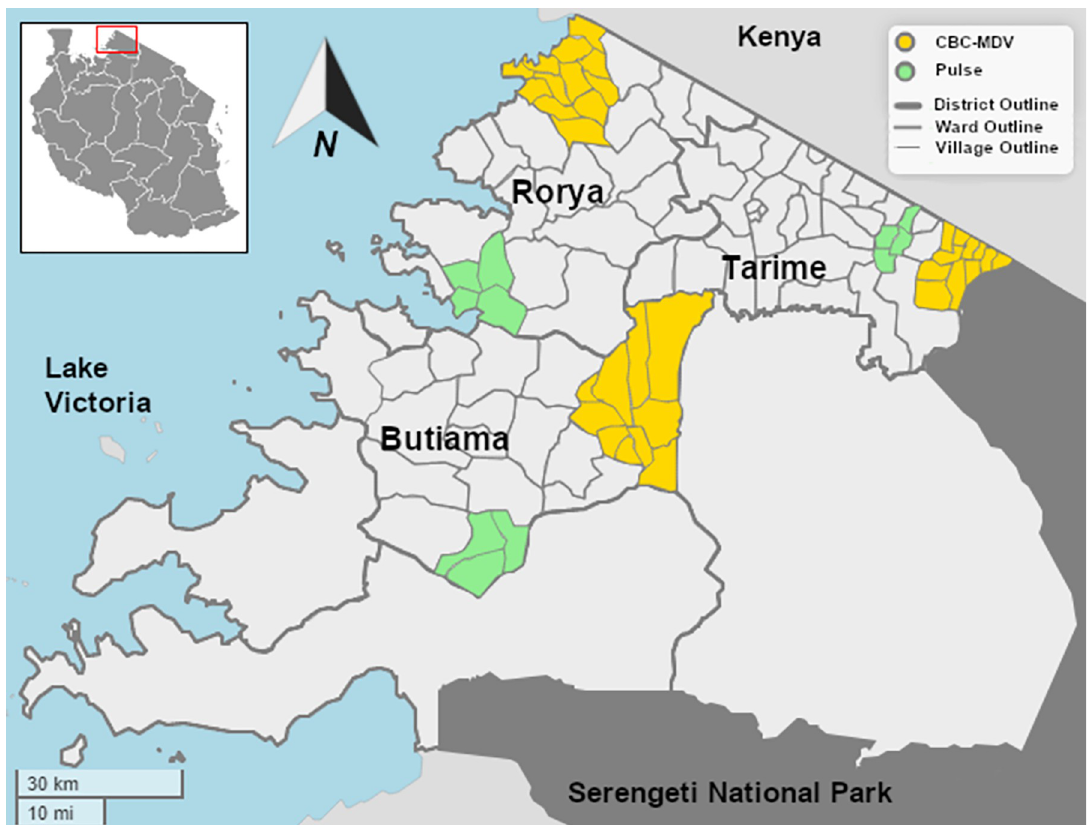
Fig 2. Map of the Mara region showing pilot districts, wards and villages. The surface areas of the 35 villages in the CBC-MDV study (split across the 3 wards) averaged 25.1km 2 , ranging from 4.6–134km 2 . The shapefiles are publicly available from the Tanzania Bureau of Statistics -